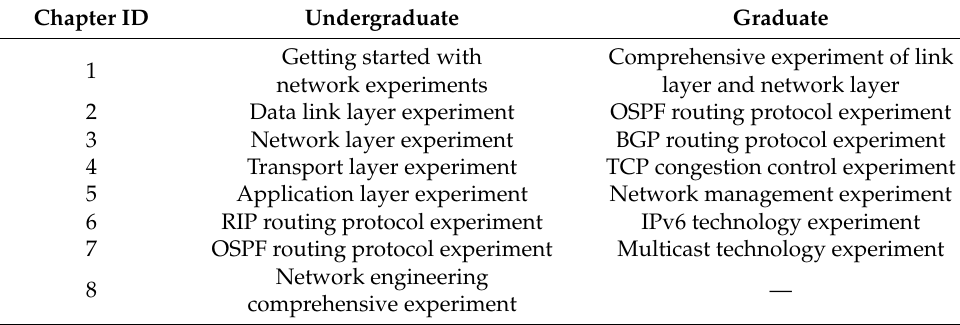
Table 1. Computer network experiment content.